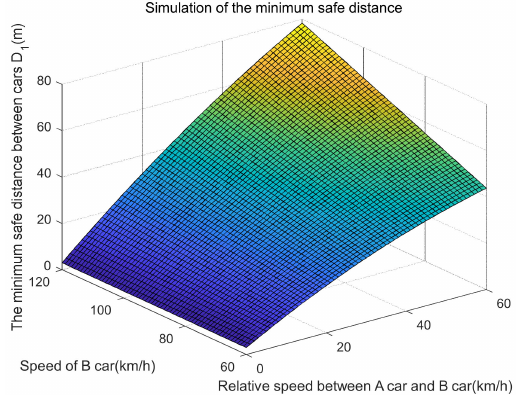
Figure 3. Changes in the minimum safe distance D 1 with various V B and V r when i = 0 and d =